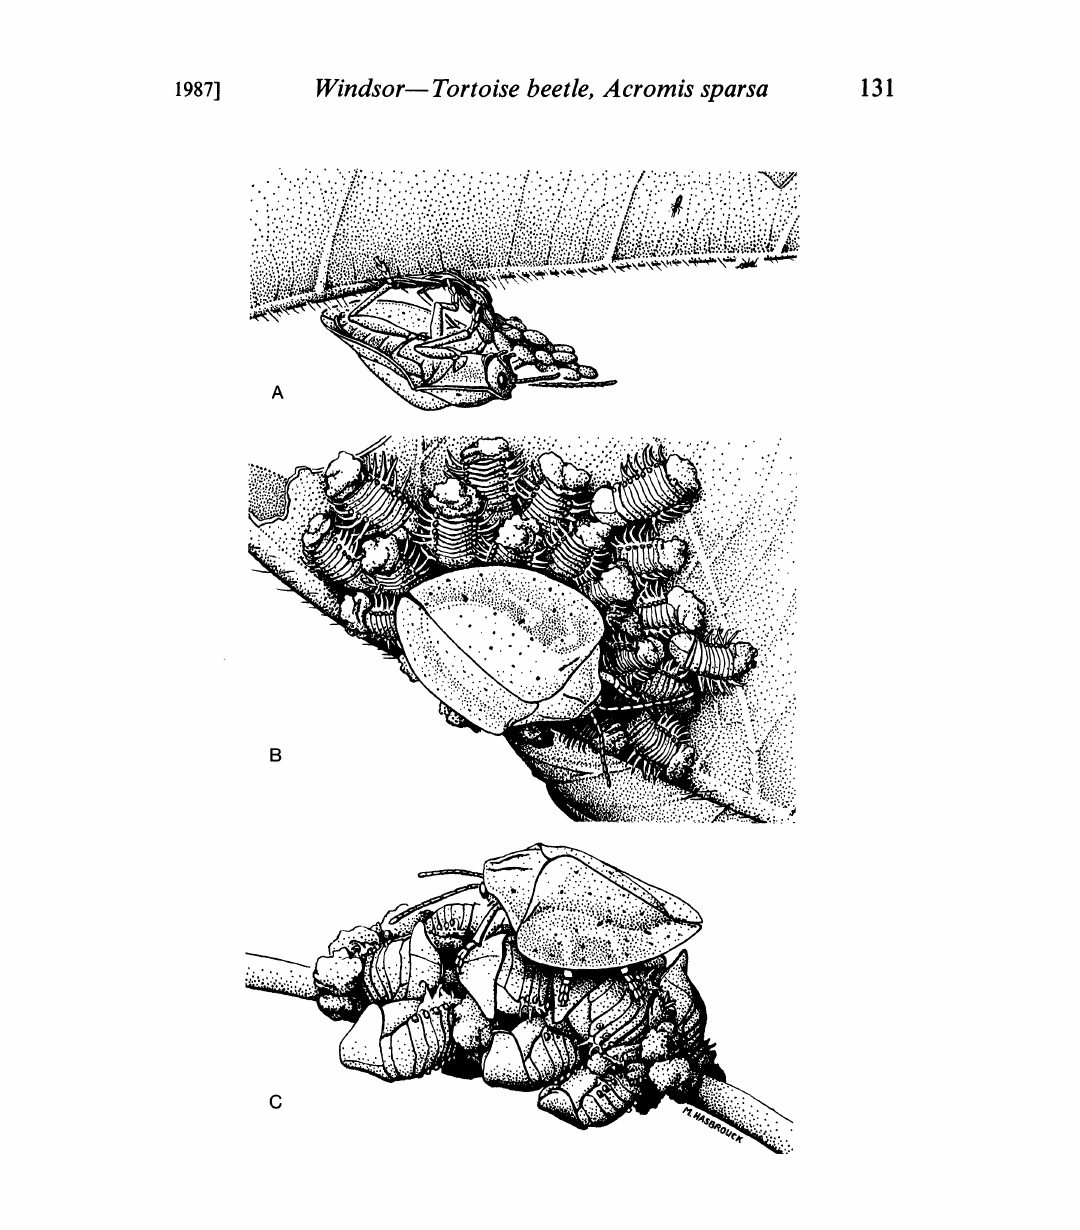
Fig. 1. Guarding postures of female Acromis sparsa. A, on an egg mass with parasites nearby; B, on medium-aged larvae aggregated on the undersurface of a Merremia leaf; and C, on a pupal mass located low on a Merremia